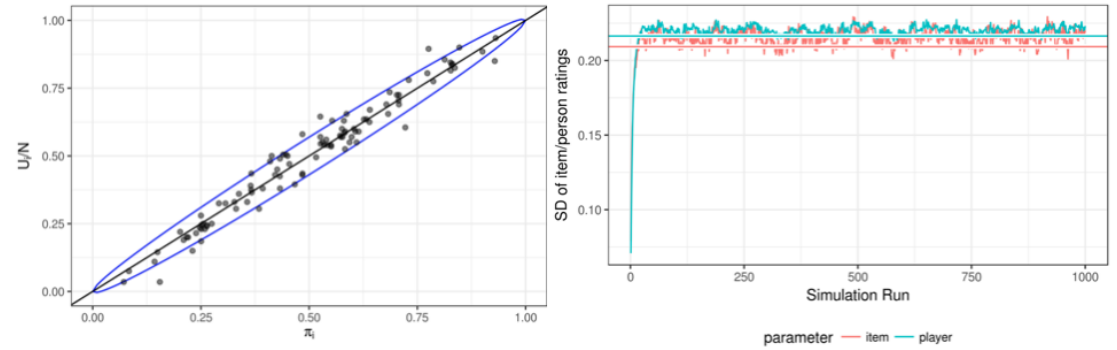
Figure 3. The left panel shows the true π i versus estimated u i / n i item ratings, and the 95% confidence interval (CI) implied by the urn size. The right panel shows the SD of the item and person ratings throughout the simulation. The horizontal lines reflect the SD based on the samples from the true values.